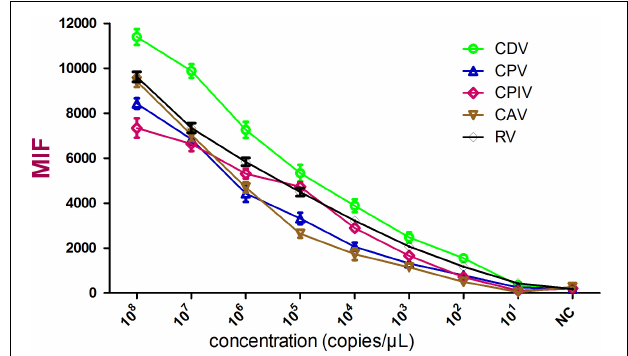
FIGURE 2 | Sensitivity analysis of the xTAG assay. Cloned gene copies from the indicated viruses were transcribed in vitro and used in triplicate. The detection limit was 100 copies/ µ L for these five viruses.